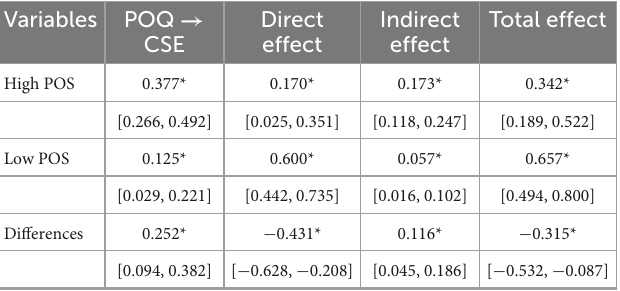
N = 286.95%confidenceintervalswerereportedintheparentheses.* p < 0.05.